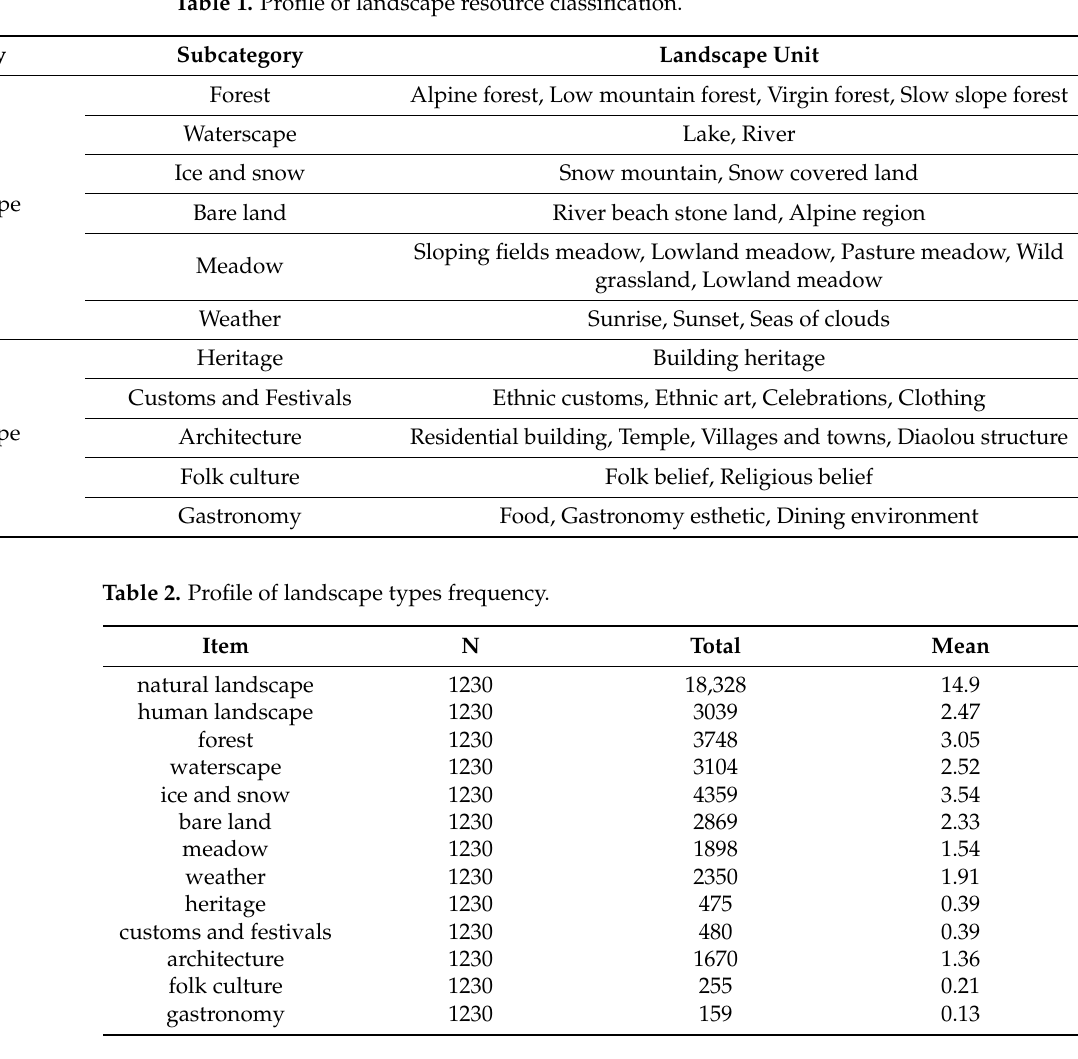
Table 1. Profile of landscape resource classification.